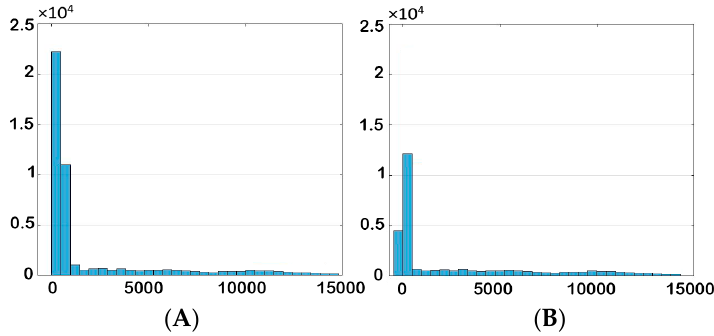
Figure 29. Histogram of pressure ( A ) before and ( B ) after elimination.